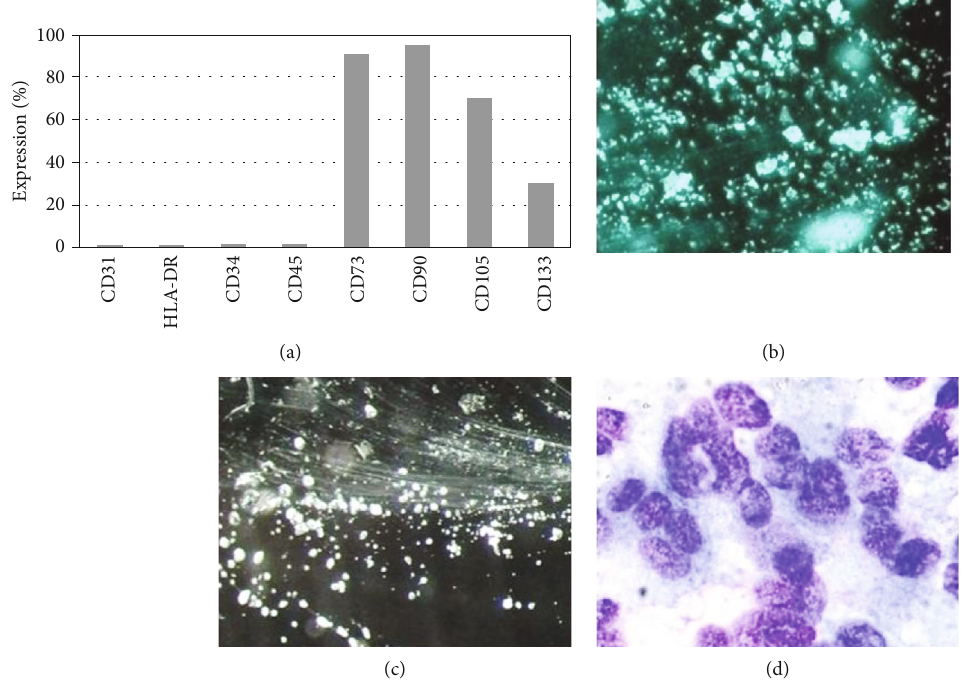
Figure 1: Immunophenotypic analysis of HPMSCs. (a) After isolation of human placental stem cells, immunophenotypical analysis was conducted with fl ow cytometry; (b) freeze-dried HPMSCs with stereoscopic microscopy ( × 20); (c) freeze-dried HPMSCs after rehydration with stereoscopic microscopy ( × 12); (d) Giemsa stain ( × 1000) of freeze-dried HPMSCs after